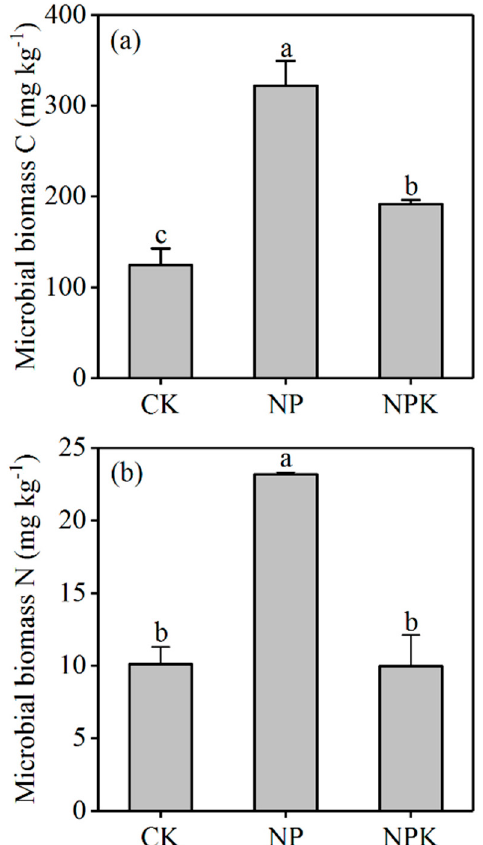
Figure 1. Comparison of soil microbial biomass C ( a ) and microbial biomass N ( b ) after 27 years of fertilization treatments (CK, no fertilizer; NP, nitrogen and phosphorous fertilizer; NPK, nitrogen, phosphorus, and potassium fertilizer) in a wheat–fallow system. Vertical bars represent the standard error ( n = 3). Different lowercase letters indicate significant differences among fertilizer treatments ( p < 0.05).